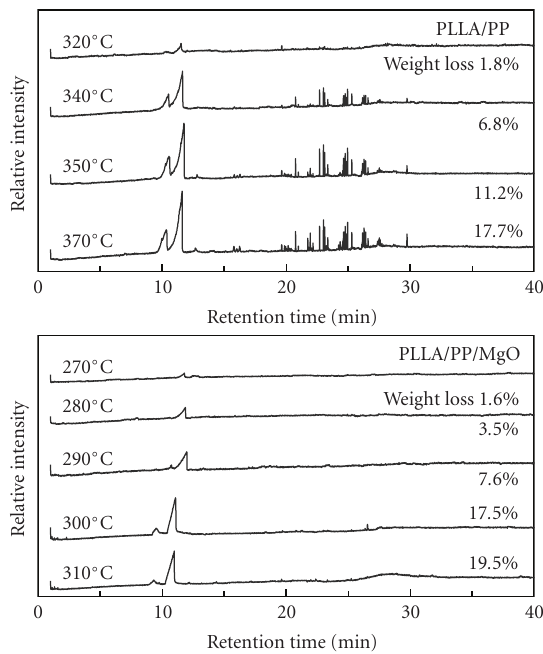
Figure 3: Pyrolysis-GC/MS analysis ( ϕ = 9 ◦ Cmin − 1 ) of PLLA/PP and PLLA/PP/MgO. Weight loss values of PLLA/PP components were estimated from TG analysis ( ϕ = 9 ◦ Cmin − 1 ).